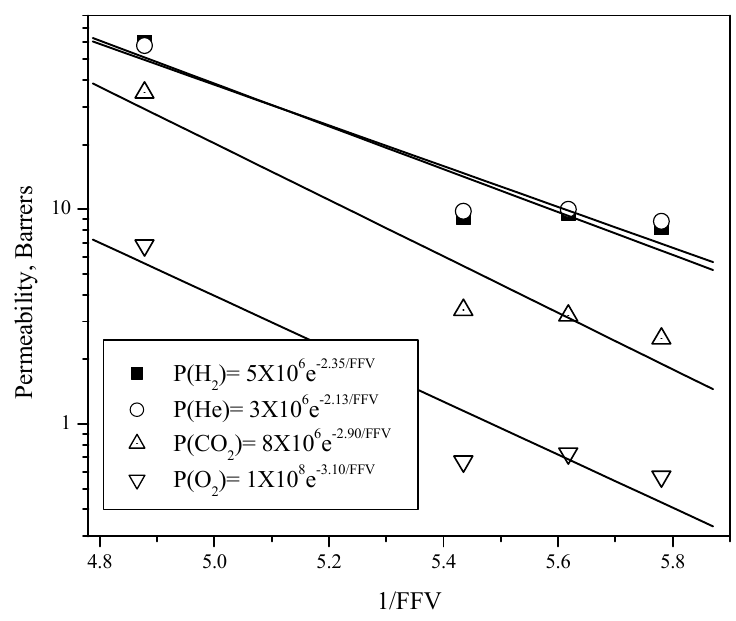
Figure 5. Gas permeability and 1/FFV relationship shown by the TMF-based polyimides.